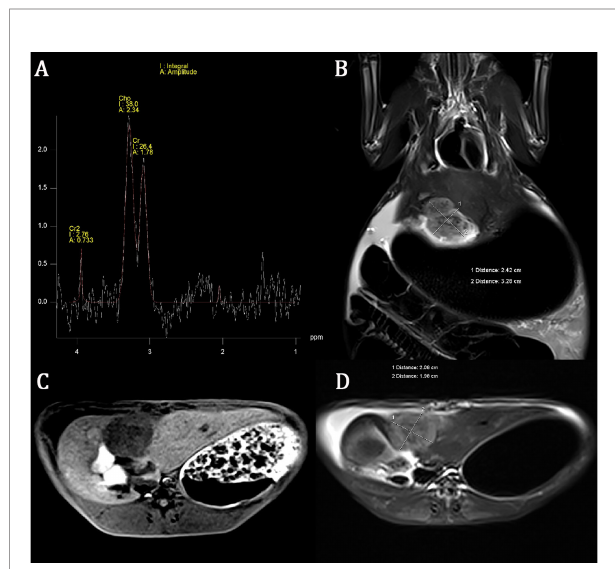
FIGURE 1 | Conventional magnetic resonance imaging (MRI) sequence and hydrogen-1 proton magnetic resonance spectroscopy ( 1 H-MRS) of liver cancer. The choline (Cho) peak at 3.22 ppm is signi fi cantly increased in liver VX2 tumor (A) . The axial and coronal images of the tumor showed hypointensity on T1- weighted imaging (T1WI) and slightly hyperintensity on T2-weighted imaging (T2WI) (B – D)